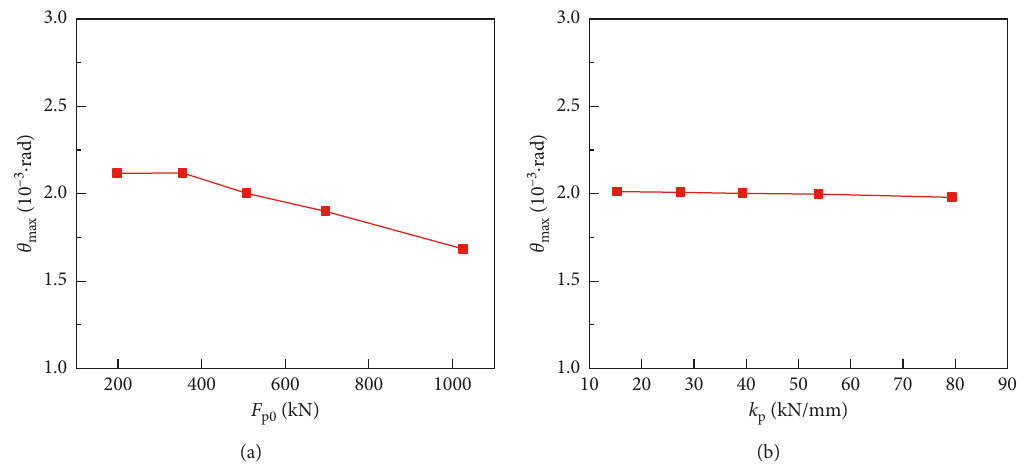
Figure 18: Effects of the parameters regarding the PT tendon. (a) F